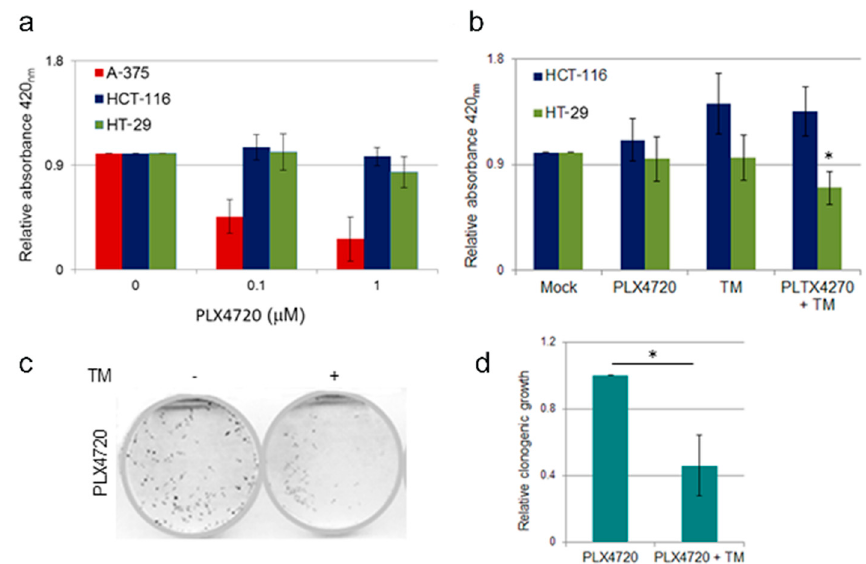
Figure 6. Effect of TM treatment on BRAF inhibitor resistant cells. ( a ) Melanoma and colon cancer cell lines show different sensitivity to PLX4720 treatment. Melanoma cell line A375 (BRAF V600E ), colon cancer HCT-116 (BRAF wt ) and HT-29 (BRAF V600E ) were treated with the increasing doses of PLX4720.